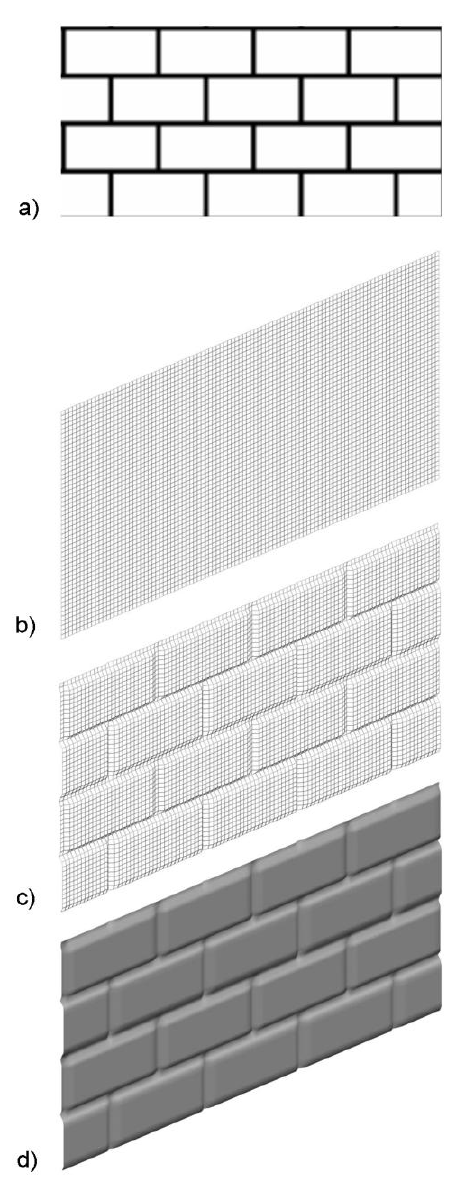
Figure 1. The displacement in